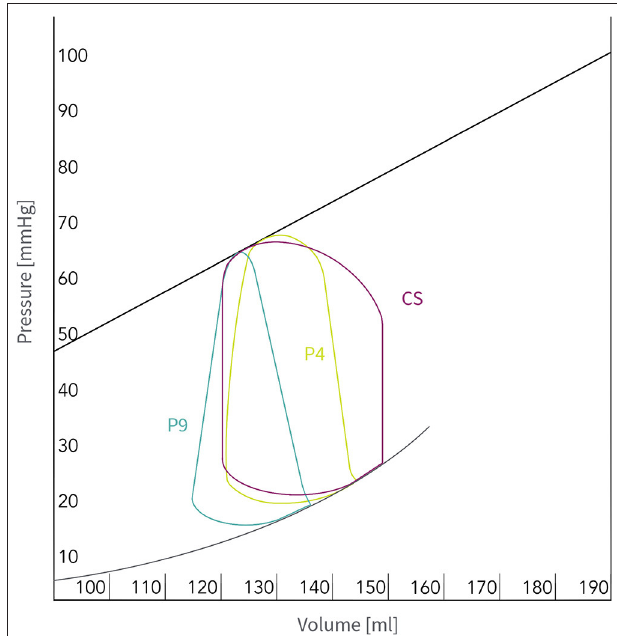
FIGURE 2 | Pressure-volume relationship on Impella TM CP support and different performance (“P”) level settings: The evolution of the pressure-volume relationship before (CS: CO 3l, PAWP 27 mmHg; purple) and after support with “P” Level 4 (2.5l flow; green) and “P” Level 9 (4l flow; turquoise). CO, Cardiac output; CS, Cardiogenic shock; PAWP, Pulmonary artery wedge pressure